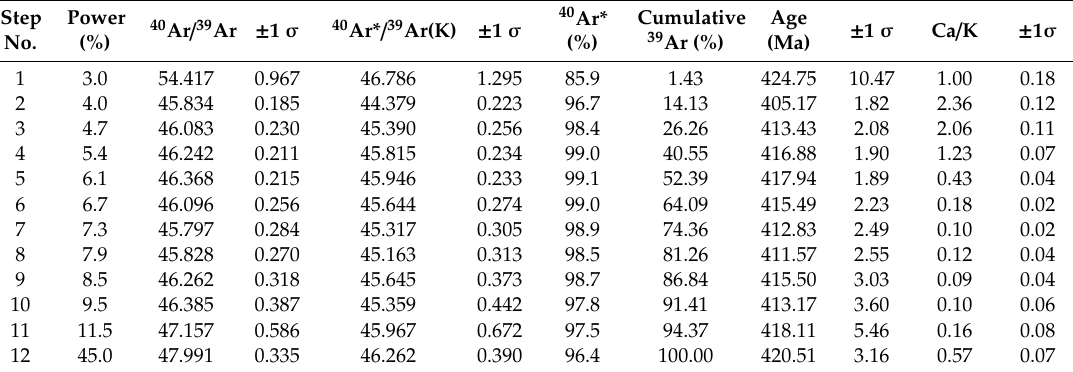
Table 8. Argon step heating data of whole-rock muscovite from sample 03-LG-1, J value =